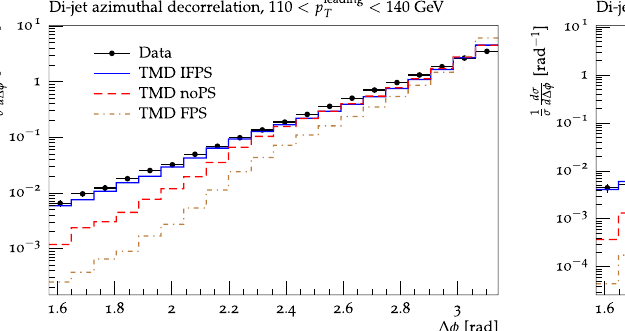
Fig. 6 (cid:4)φ distribution of high p t dijet events for different regions of p leading t : without parton shower (noPS, dashed red line), with final